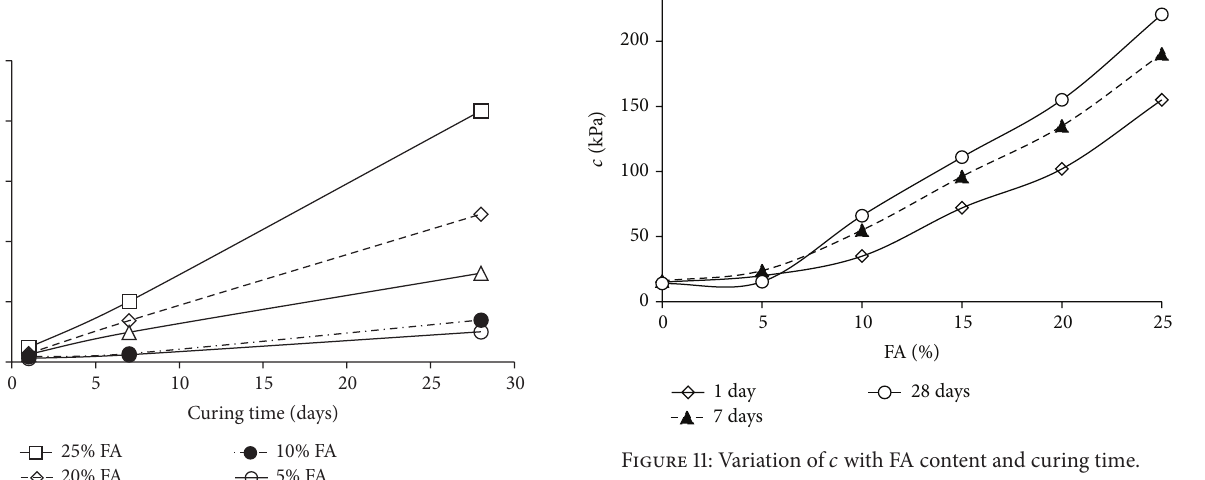
Figure 8: The effects of the curing time and FA content on the CBR values.